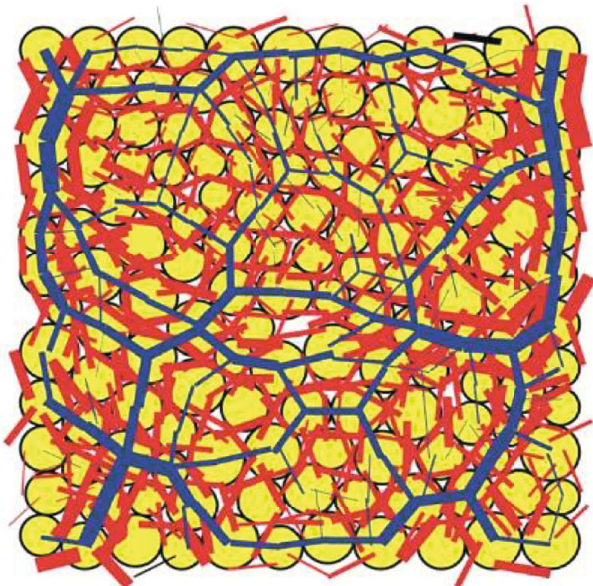
Figure 5: Principle of parallel bonding. The red and blue lines in the fi gure represent the contact surfaces of the two elements, respectively. In the bonded state, the two elements are bonded, and the contact force between the elements is the algebraic sum of the contact force and the bonding force. The bonded state will be destroyed after the bonding force reaches a certain value, after which only contact force exists between the